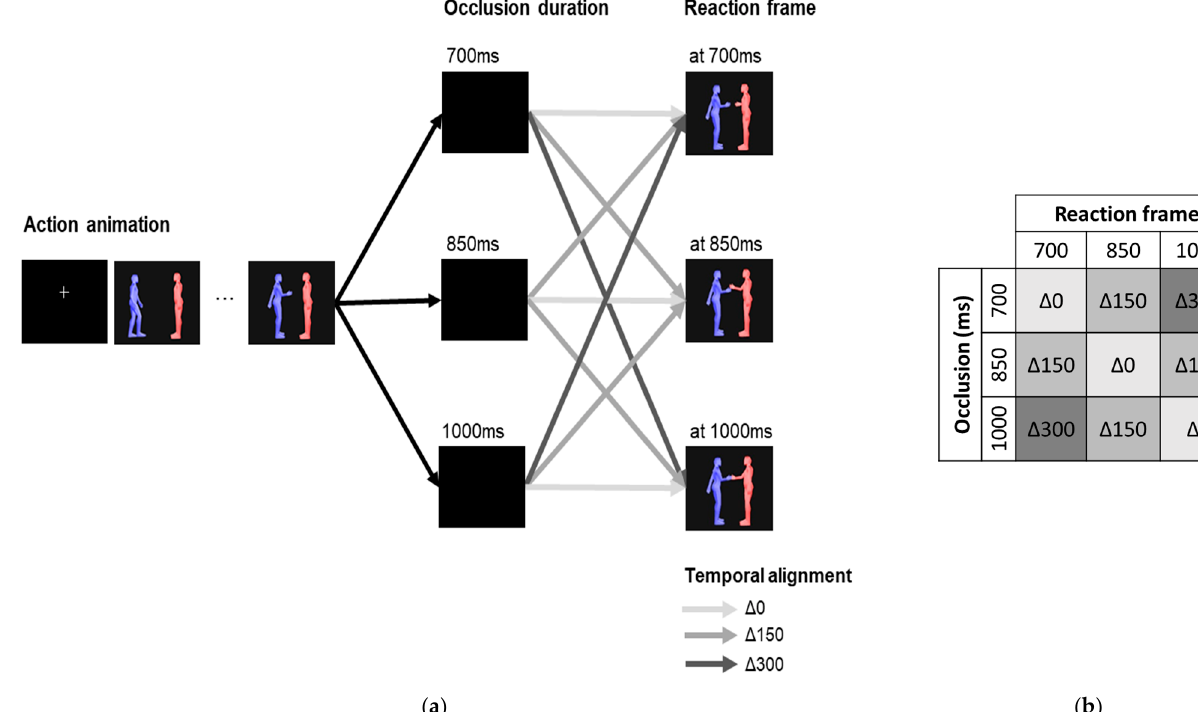
Figure 3. Experimental design. ( a ) The stimuli presentation stages within each trial. Trials began with a 3000 ms animation of a blue character performing a social action (e.g., blue reaches to shake red’s hand). A black occlusion frame then blocked the animation. Following this, a frame representing a specific instant of the red character’s reaction was shown (e.g., red reaches its hand forward). ( b ) The three occlusion durations (700, 850, 1000 ms) were independently combined with the three different reaction frames (at 700, at 850, at 1000 ms) to generate the temporal alignment conditions: Δ 0—the moment depicted in the reaction frame is temporally aligned with the duration of the occlusion; Δ 150—the moment showed in the reaction frame occurs 150 ms before or after the occlusion duration; Δ 300—the moment depicted in the reaction frame occurs 300 ms before or after the occlusion duration.